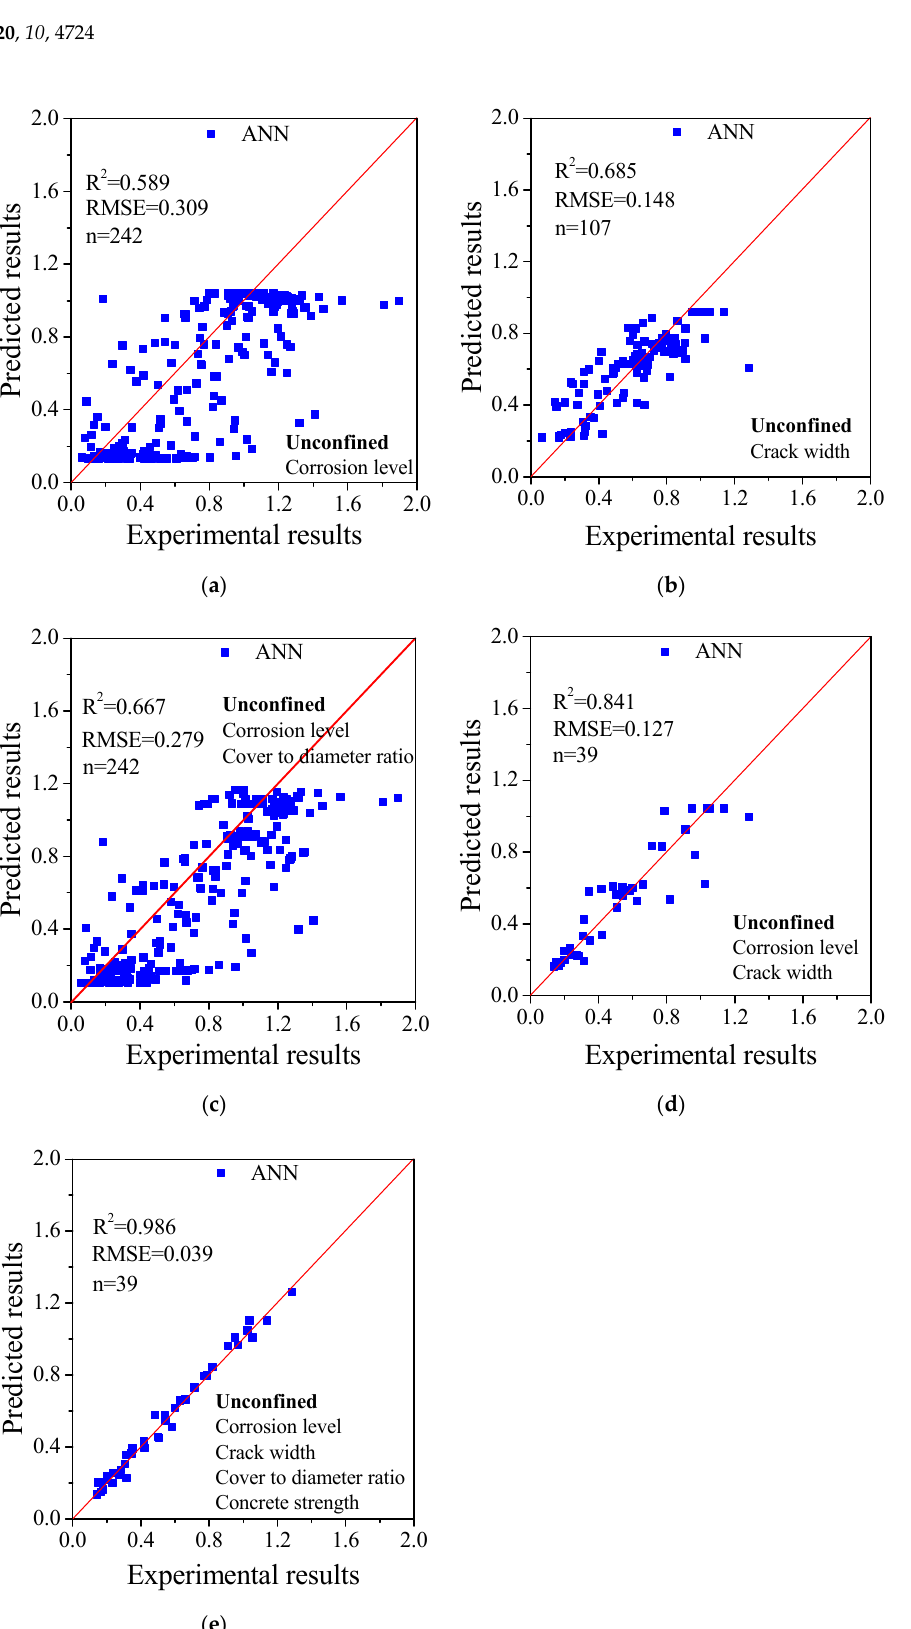
Figure 9. Comparison of the results calculated by ANN method considering di ff erent parameters for the unconfined cases: ( a ) corrosion level; ( b ) crack width; ( c ) corrosion level and cover to diameter ratio; ( d ) corrosion level and crack width; ( e ) corrosion level, crack width, cover to diameter ratio and concrete